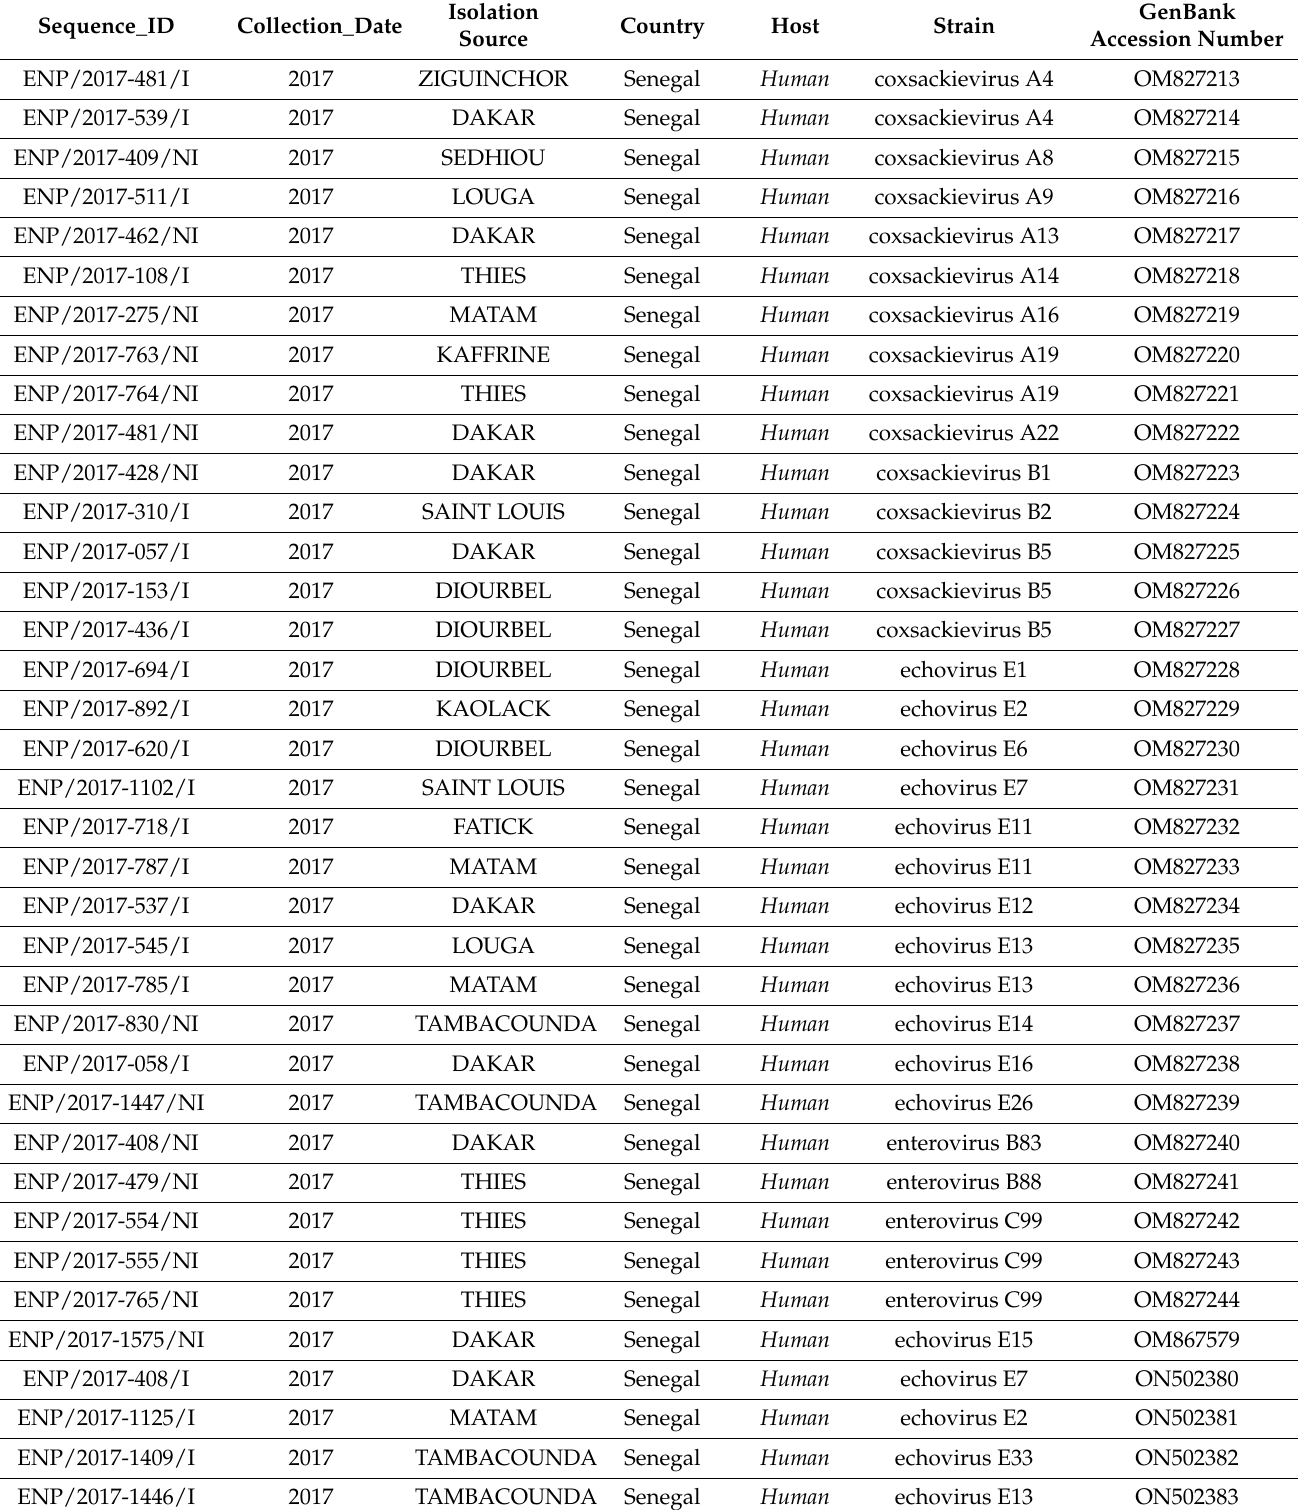
Table A1. Information Sample Characterized in This